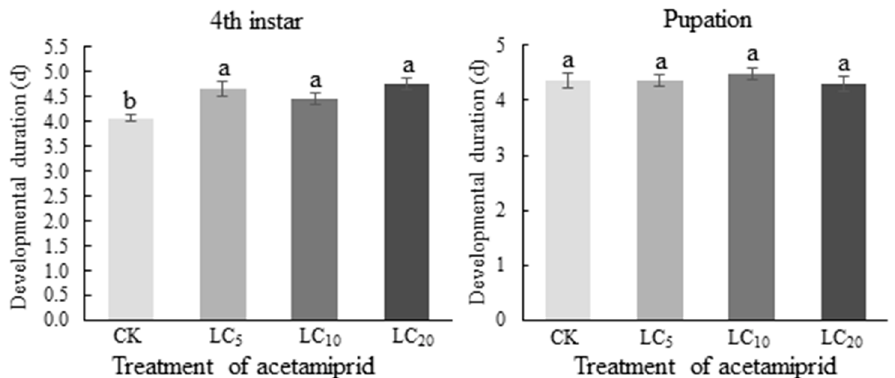
Figure 4. Effects of acetamiprid on developmental duration of C. septempunctata within 4th instar larval stage (mean ± SE). The same column followed by different letters is significantly different based on ANOVA using Tukey’s LSD test ( p < 0.05).